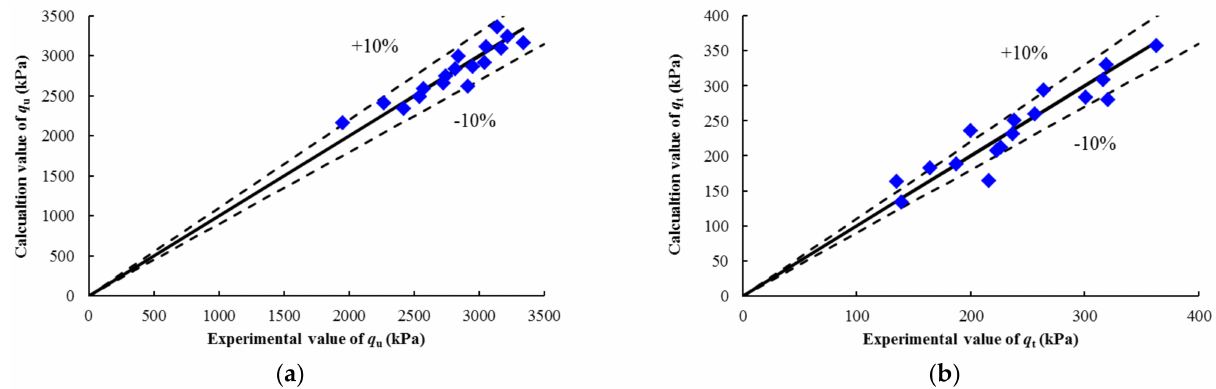
Figure 10. Comparison between strength calculation value and test value of NFLS: ( a ) UCS; ( b ) STS.